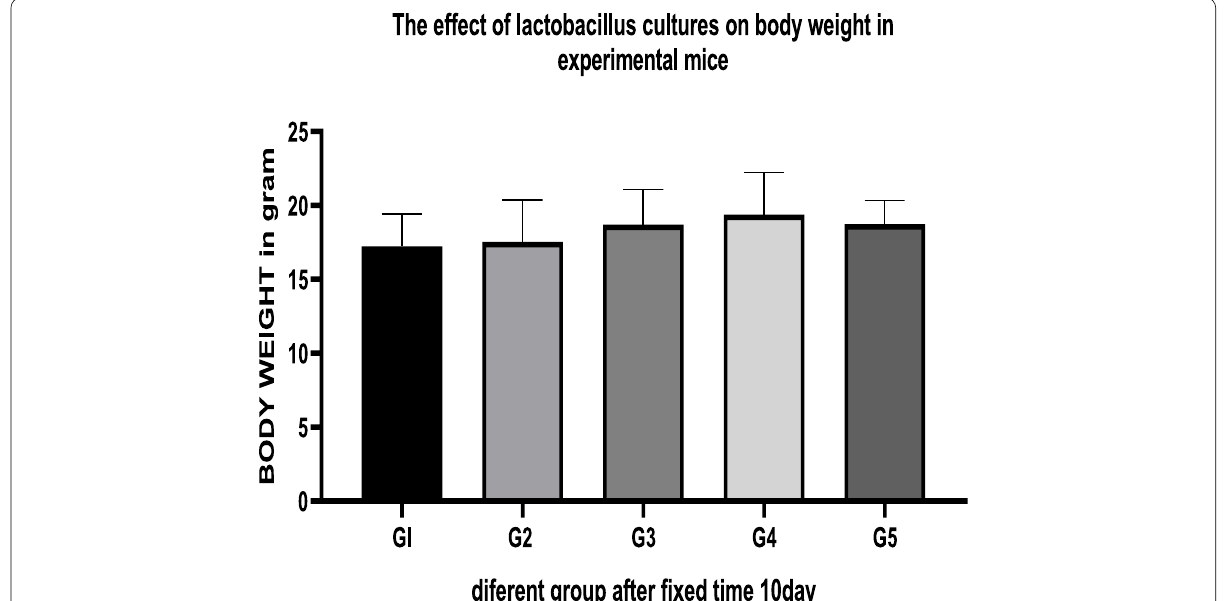
Fig. 2 The effect of lactobacillus cultures on body weight in Experimental mice for 10 days